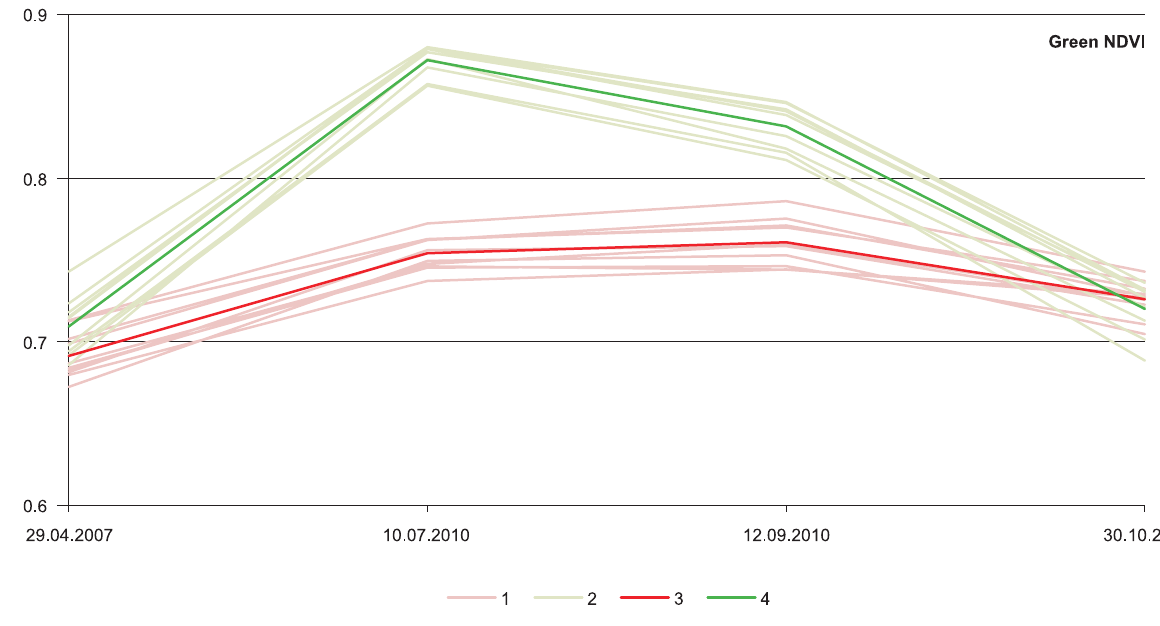
Fig. 5. Variation in the Green NDVI indices of pine and beech stands on each date in the vegetation season 1 – variation in indices for test areas of pine; 2 – variation in indices for test areas of beech; 3 – average index for pine stand; 4 – average index for beech stand